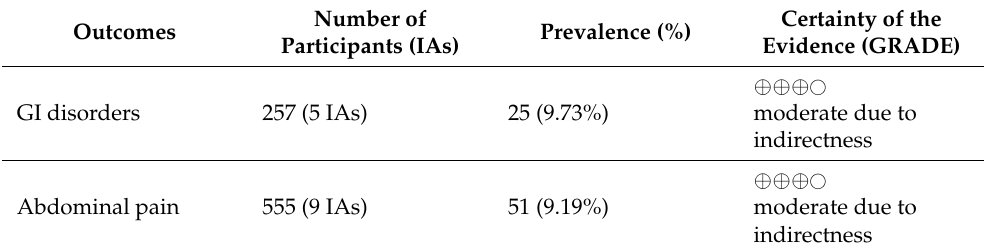
Table 9. Summary of ISO therapy adverse events: gastrointestinal changes.